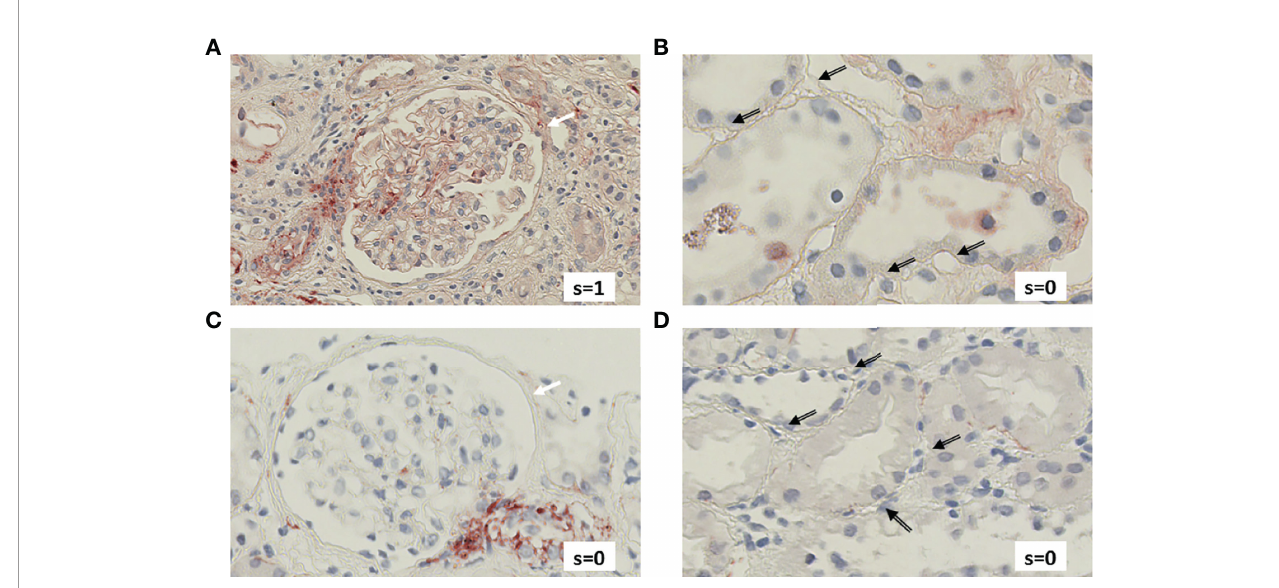
FIGURE 5 | Renal biopsy staining for complement factors in a KTR diagnosed with aTCMR. Selected section of biopsy slide stained for C3d in glomeruli (A) and in peritubular capillaries (B) . Selected section of biopsy slide stained for C5b-9 in glomeruli (C) and in peritubular capillaries (D) . White arrows indicate glomeruli and black arrows indicate peritubular capillaries. Semi-quantitative scores (0-4) are indicated in the lower right corner of each picture. KTR, kidney transplant recipients; aTCMR, acute T-cell-mediated rejection; s, semi-quantitative score.